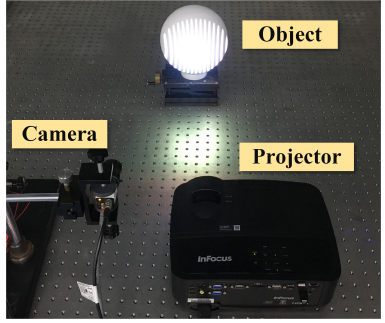
Figure 7. Experimental